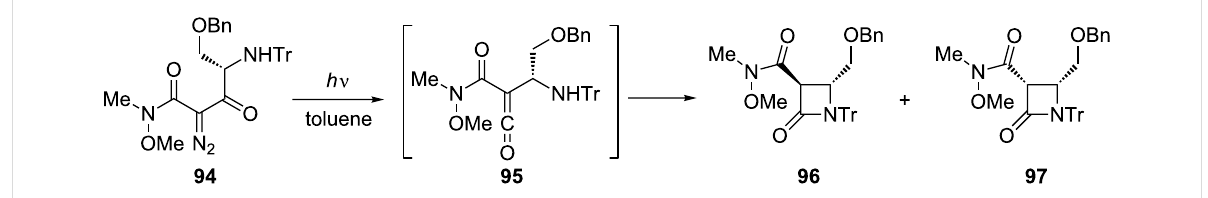
Scheme 32: Photochemical Wolff rearrangement and cyclisation to β -lactams.